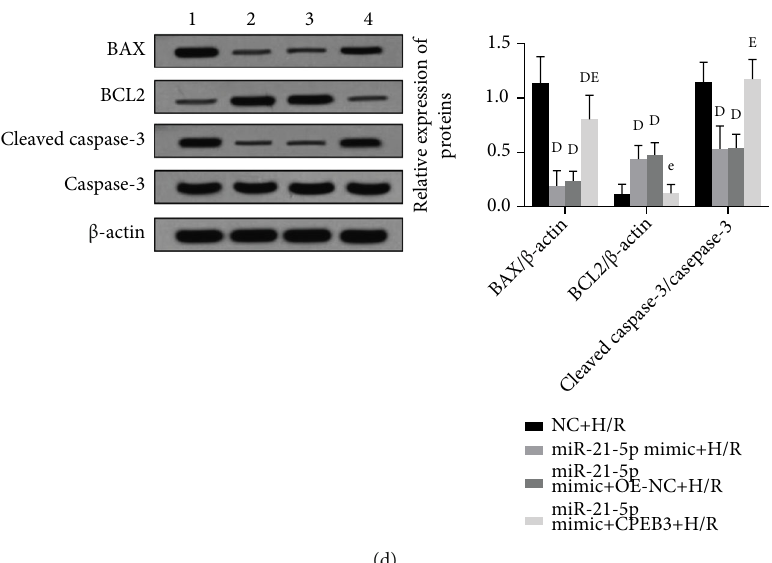
Figure 6: The e ff ect of simultaneous overexpression of miR-21-5p and CPEB3 on H/R-induced cell damage ( n = 3 ). (a) The e ff ect of simultaneous overexpression of miR-21-5p and CPEB3 on H/R-induced cell viability. (b) The e ff ect of cotransfection of cells with miR- 21-5p mimic and CPEB3 on H/R-induced apoptosis. (c) The e ff ect of simultaneous overexpression of miR-21-5p and CPEB3 on the expression of apoptosis-related proteins in H/R-induced cell. The experimental groups are as follows: 1: NC+H/R group; 2: miR-21-5p mimic+H/R group; 3: miR-21-5p mimic+OE-NC+H/R group; 4: miR-21-5p mimic+CPEB3+H/R group. Note: Student ’ s t -test was used. Compared with the NC+H/R group, d P < 0 : 05 ; compared with the miR-21-5p mimic+H/R group, e P < 0 : 05 . Table 2: The e ff ects of miR-21-5p and CPEB3 on SOD, MDA, and LDH activity in H/R-induced cells ( n = 3 , mean ± SD ). Indicators